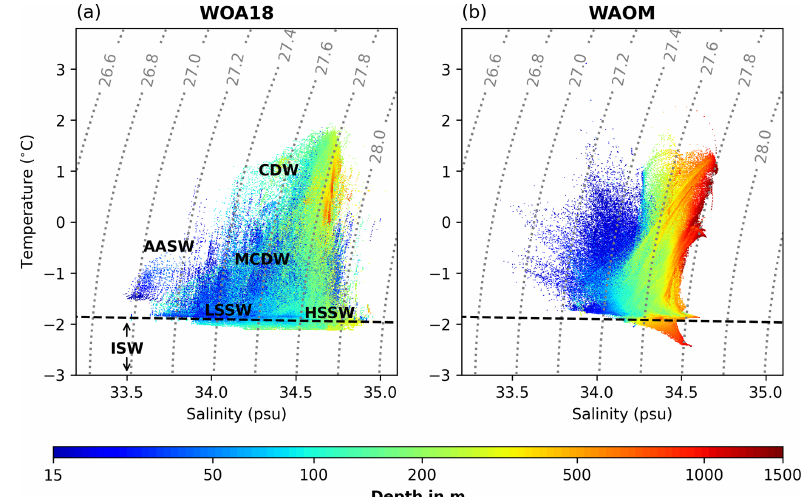
Figure 8. On-shelf summer water masses from (a) WAO18 and (b) WAOM. Shown are the potential temperature–salinity–depth distributions of the continental shelf ocean (south of 1500m isobath and excluding sub-ice-shelf cavities) averaged over December, January, and February. WOA18 is the seasonal climatology from 2005 to 2017, while WAOM is 2007 only. The uppermost 15m is excluded for reasons given in the text (see Sect. 2.6). Each product has been analysed on its original grid. For the analysis, each grid cell has been sorted into 1000 × 1000 temperature and salinity bins, and the depth shown for each bin is the volume-weighted average of all the grid cells in this bin. The dashed black lines show the freezing point at the surface, and the dotted grey lines are potential density anomaly contours (in kgm − 3 − 1000; referenced to the surface). Labels show different water masses referred to in the text: CDW indicates Circumpolar Deep Water, MCDW indicates Modified Circumpolar Deep Water, LSSW indicates low-salinity shelf water, HSSW indicates high-salinity shelf water, AASW indicates Antarctic Surface Water, and ISW indicates Ice Shelf Water. WAOM presents a lack of HSSW and a bias towards warm waters at shallow and intermediate